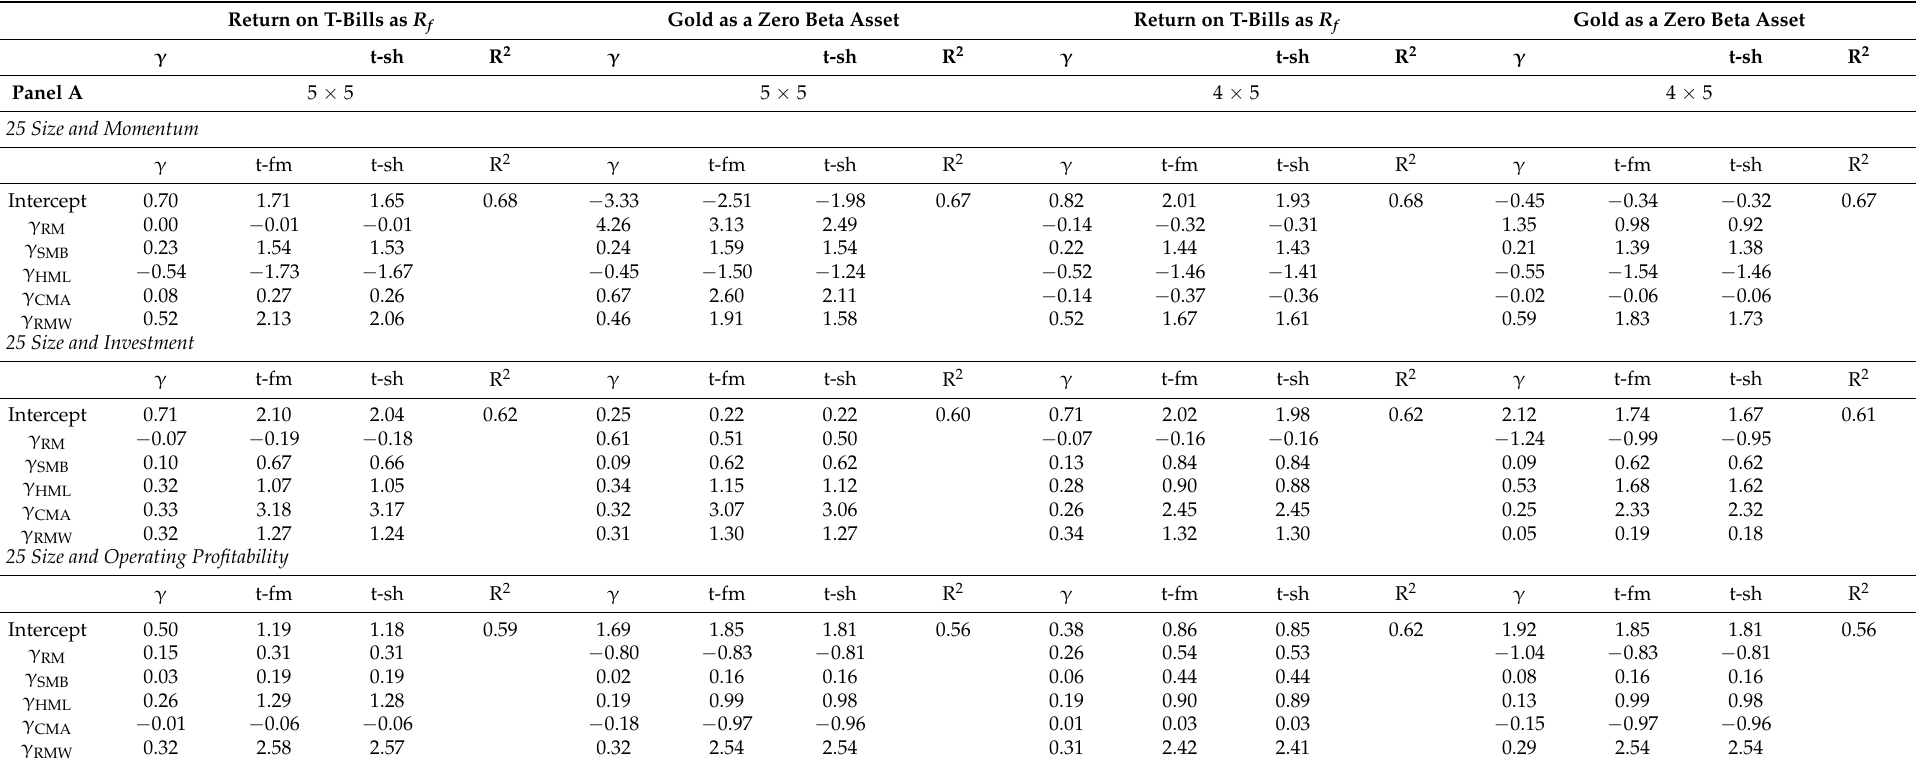
Table 17. Fama–MacBeth tests for five-factor and G-five-factor model from January 1981 to December 2015. Results represent monthly percent returns. γ is the average coefficient, t-fm is the t-statistics from Fama–MacBeth procedure, t-sh is the Shanken (1992) errors-in-variables corrected t-statistic, and R 2 is the average cross-sectional R-squared of the tested models. Panel A shows results on 25 size and momentum, size and investment and 25 size and operating profitability portfolios, Panel B shows results on 32 size, book-to-market, and operating profitability; 32 size, book-to-market and investment portfolios; and 32 size, operating profitability and investment portfolios, and Panel C shows results on 35 size and net share issues portfolios. All results are shown with (5 × 5) and without microcaps (4 ×